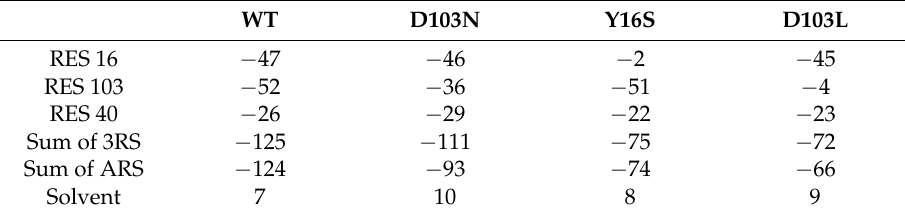
Table 2. The calculated average electric fields on the C=O group of 19-NT (in MV/cm) exerted by residues 16, 103, 40, and the solvent in wild-type and variants (D103N, Y16S, D103L) of KSI. “Sum of 3RS” denotes the sum of the electric field exerted by the three residues 16, 103 and 40. “Sum of ARS” denotes the sum of the electric field exerted by all residues in protein and solvent. “Solvent” denotes the electric field exerted by solvent. The electric field is calculated using the Amber ff99SB charge model from QM/MM MD sampling. WT D103N Y16S D103L RES 16 −